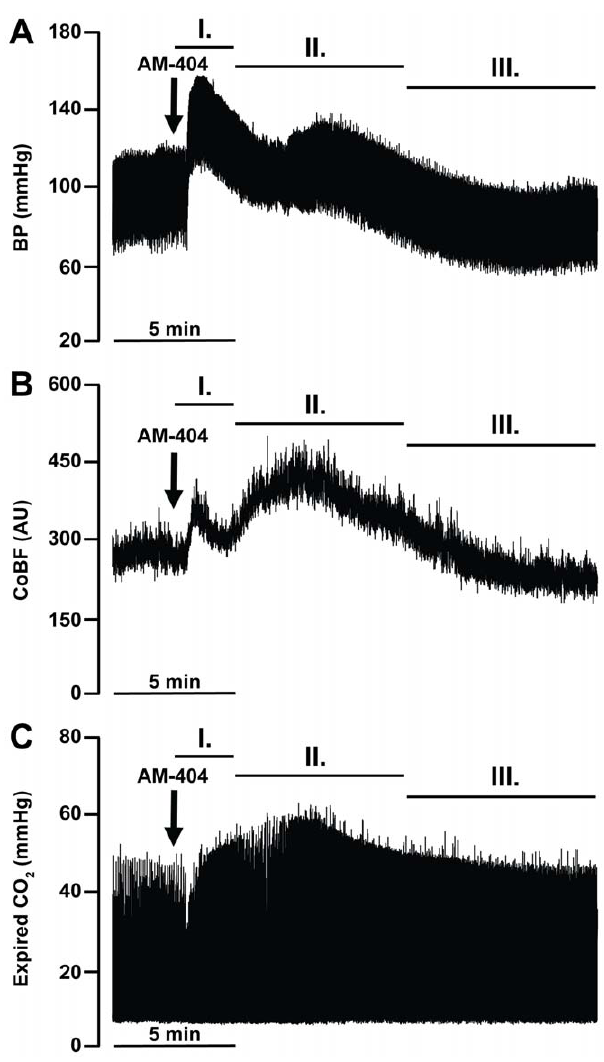
Figure 2. Representative recordings of the effects of endocan- nabinoid reuptake inhibition on blood pressure (A), cerebro- cortical blood flow (B) and expired CO 2 levels (C). After the intravenous administration of 10 mg kg 2 1 AM-404 a transient increase in blood pressure (BP) and cerebrocortical blood flow (CoBF) can be seen (phase I). It is followed by a second prominent increase in CoBF (phase II) that is accompanied with a rise of expired CO 2 . Thereafter a sustained decrease in the BP and CoBF can be seen (phase III). The arrows indicate the injection of AM-404.